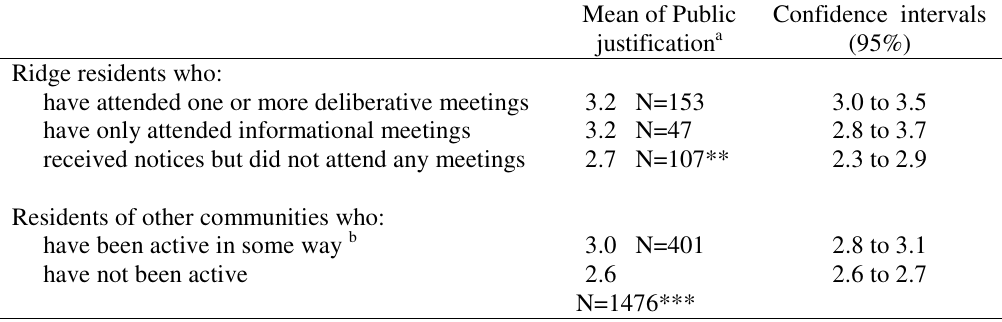
Table 2. Mean (on a 0 to 6 scale) of public justification assessments of public justification with and without deliberative participation, controlling for political